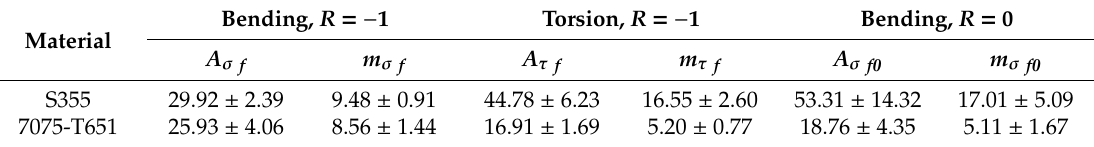
Table 5. Regression coe ffi cients of the fatigue characteristics with intervals for a 95% confidence level.